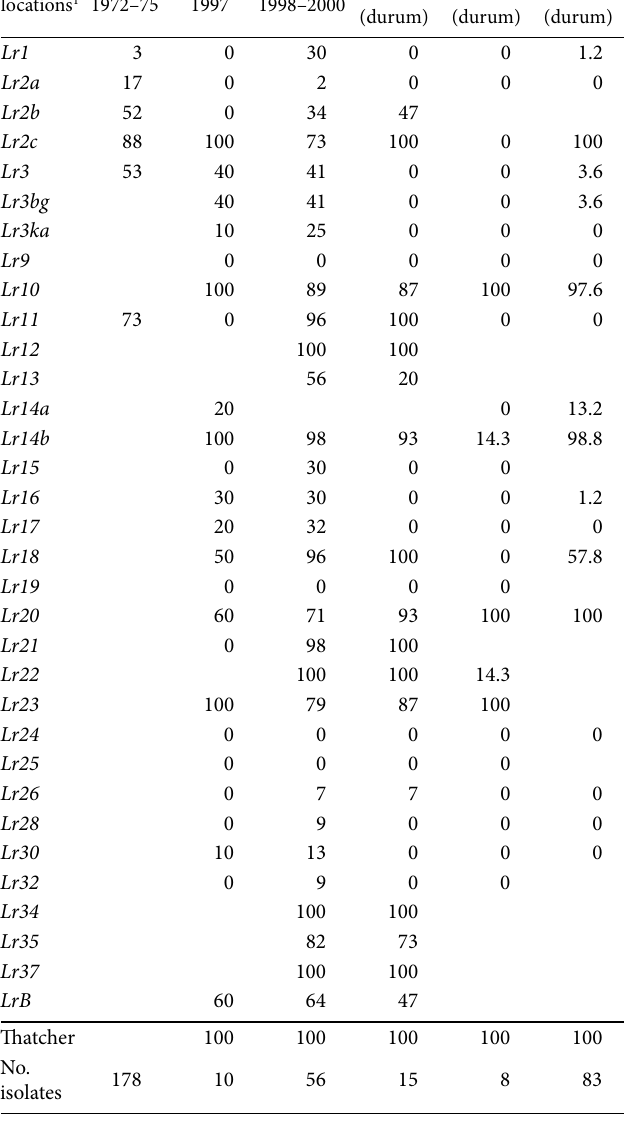
Table 4. Frequency of Puccinia triticina (leaf or brown rust) isolates virulent on Thatcher near–isogenic lines, collected in Spain and Andalusia in different